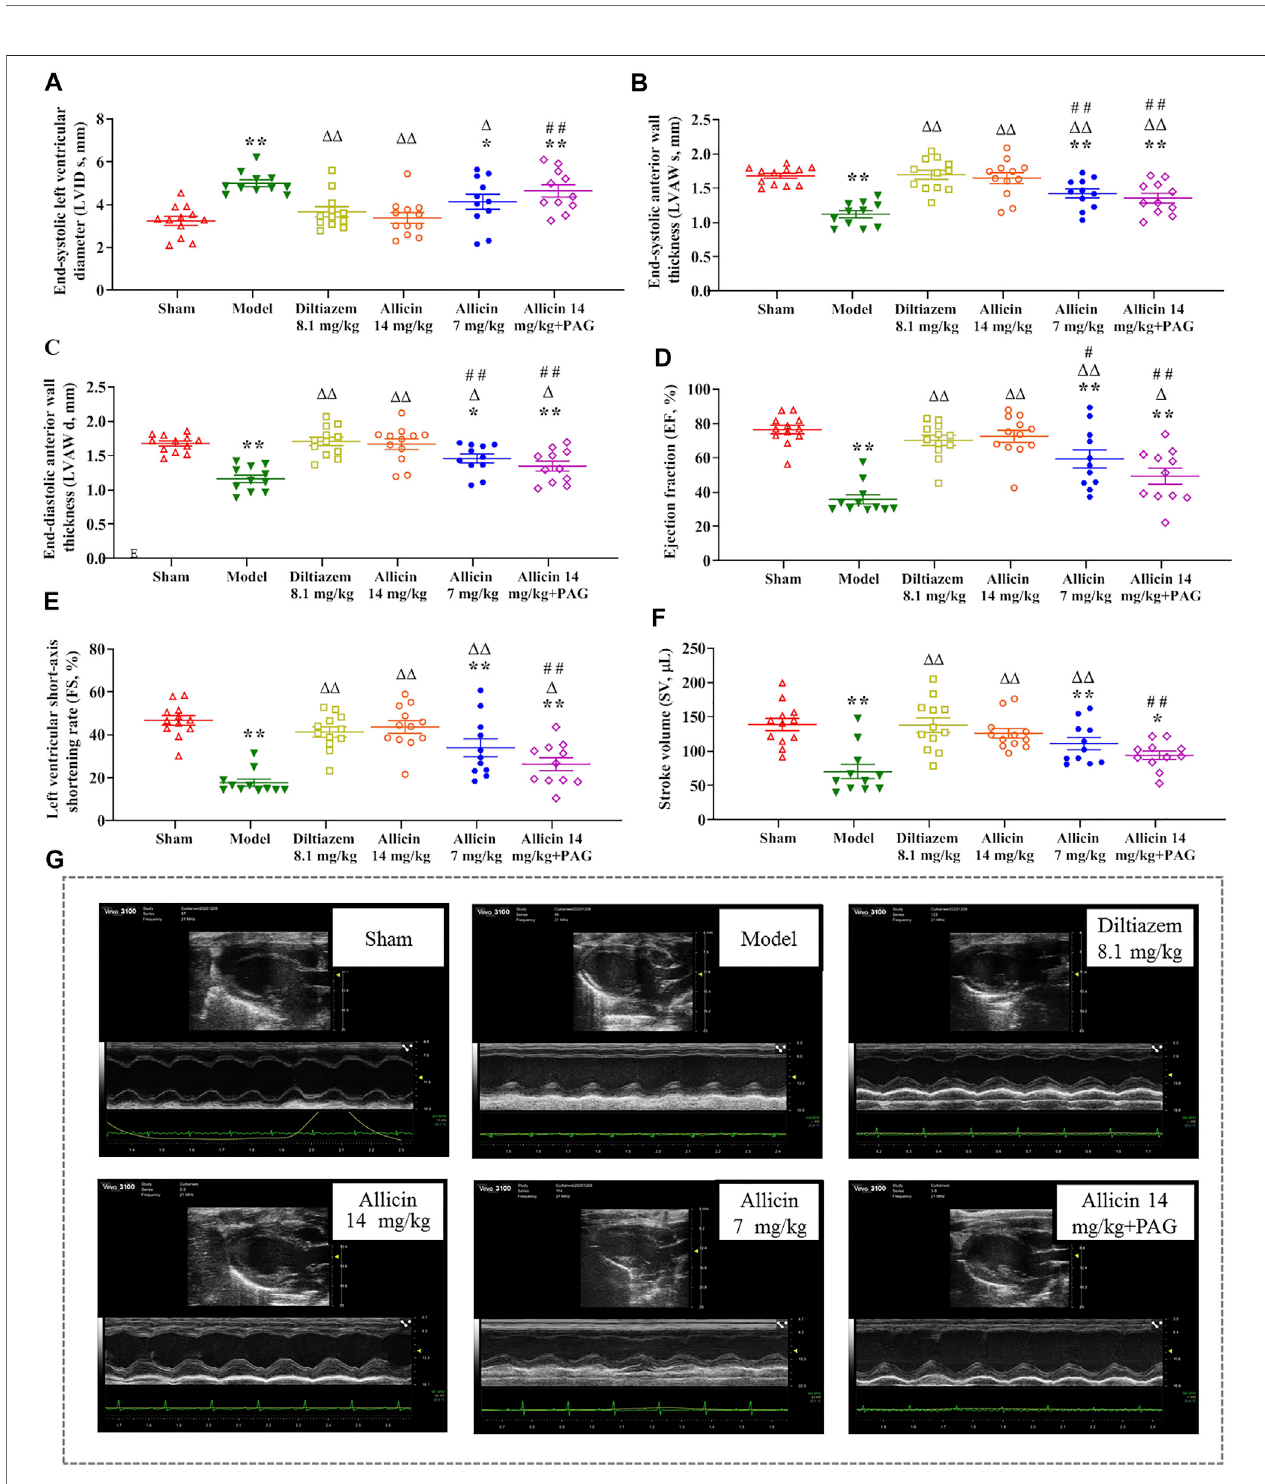
FIGURE1| Allicinimproved cardiac functioninAMImodelrats. (A ‒ F) Thestatisticalscatter plotsof (A) LVIDs, (B) LVAWs, (C) LVAWd, (D) EF, (E) FS,and (F) SV in the experimental and control groups. (G) Representative images of ultrasonic function in experimental and control groups. Data are expressed as mean ± S.E.M ( n (cid:1) 11 – 12). * p < 0.05, ** p < 0.01 vs. control; △ p < 0.05, △△ p < 0.01vs. the Modelgroup; # p < 0.05, ## p < 0.01 vs. theAllicin 14 mg/kg group. Abbreviations:LVID s, left ventricular internal diameter end systole; LVAW s, left ventricular end-systolic anterior wall thickness; LVAW d, left ventricular end-diastolic anterior wall thickness; EF, ejection fraction; FS, functional shortening; SV, stroke volume; PAG, DL-propargylglycine.